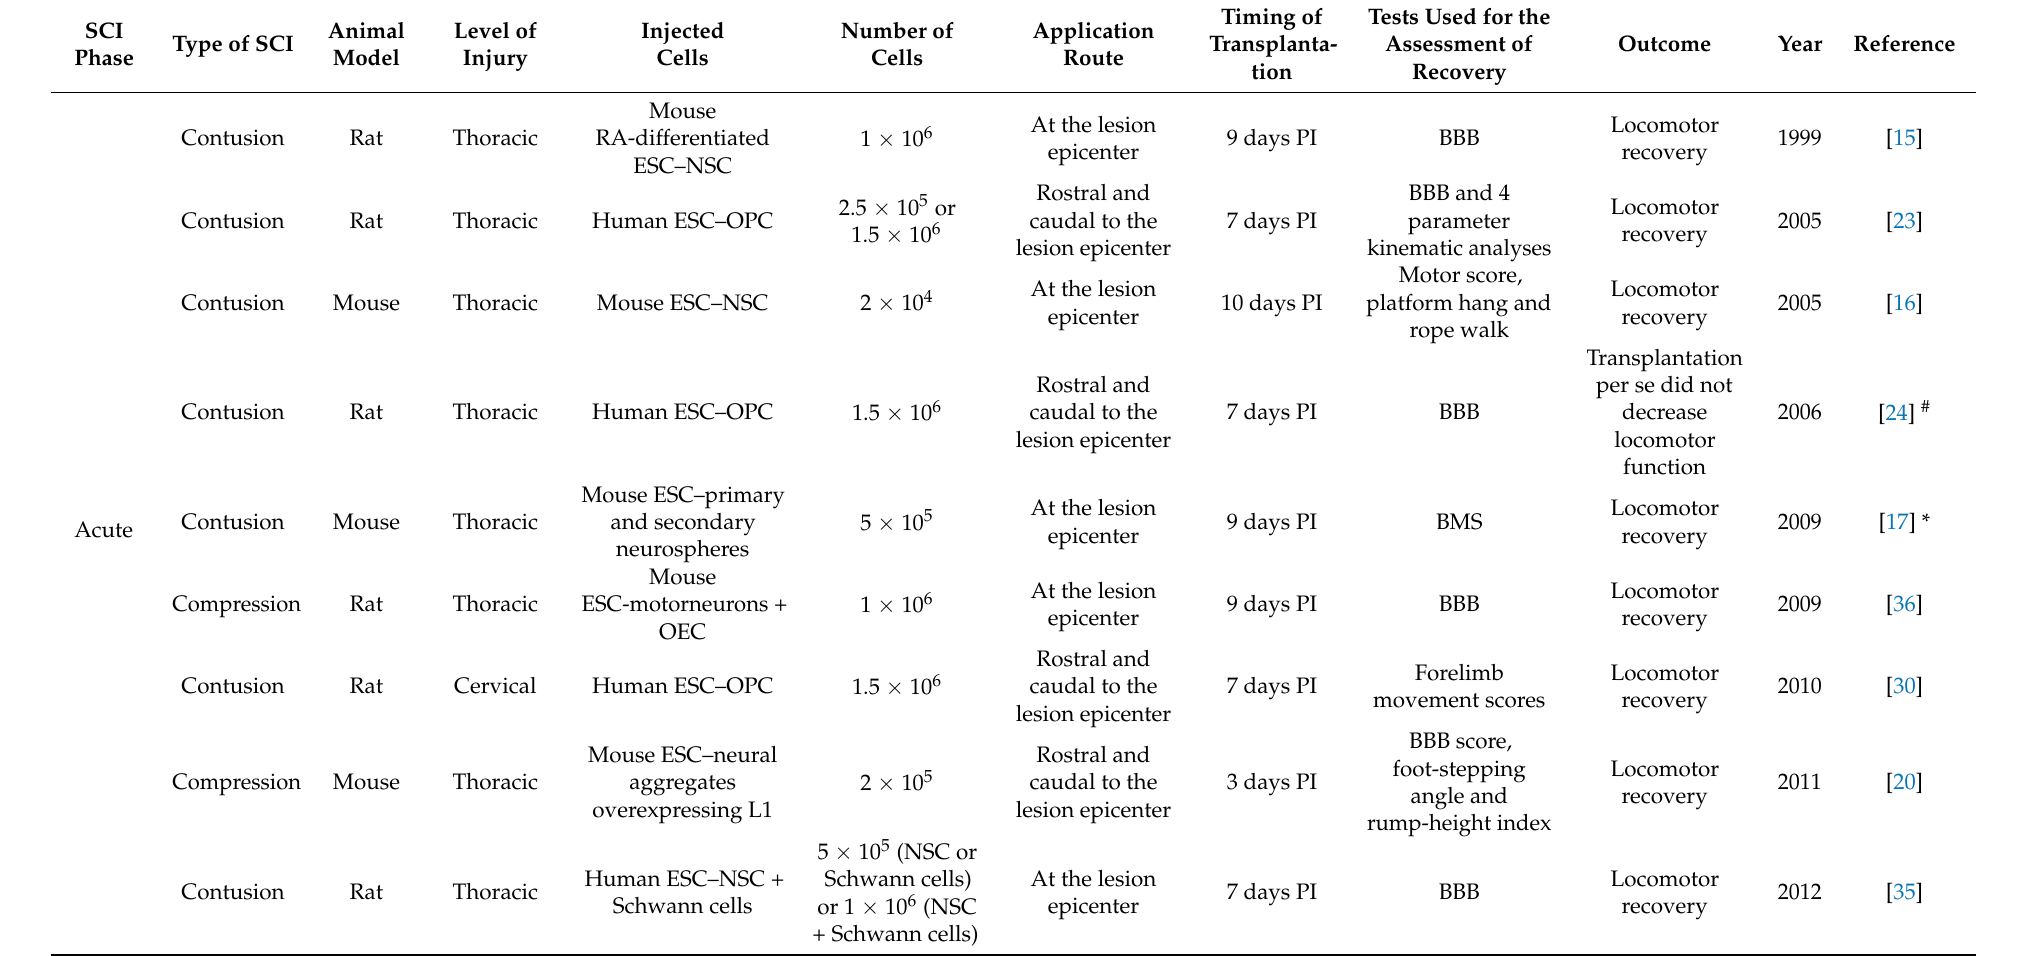
Table 1. Selected studies carried out with PSC-derived cells for acute and chronic